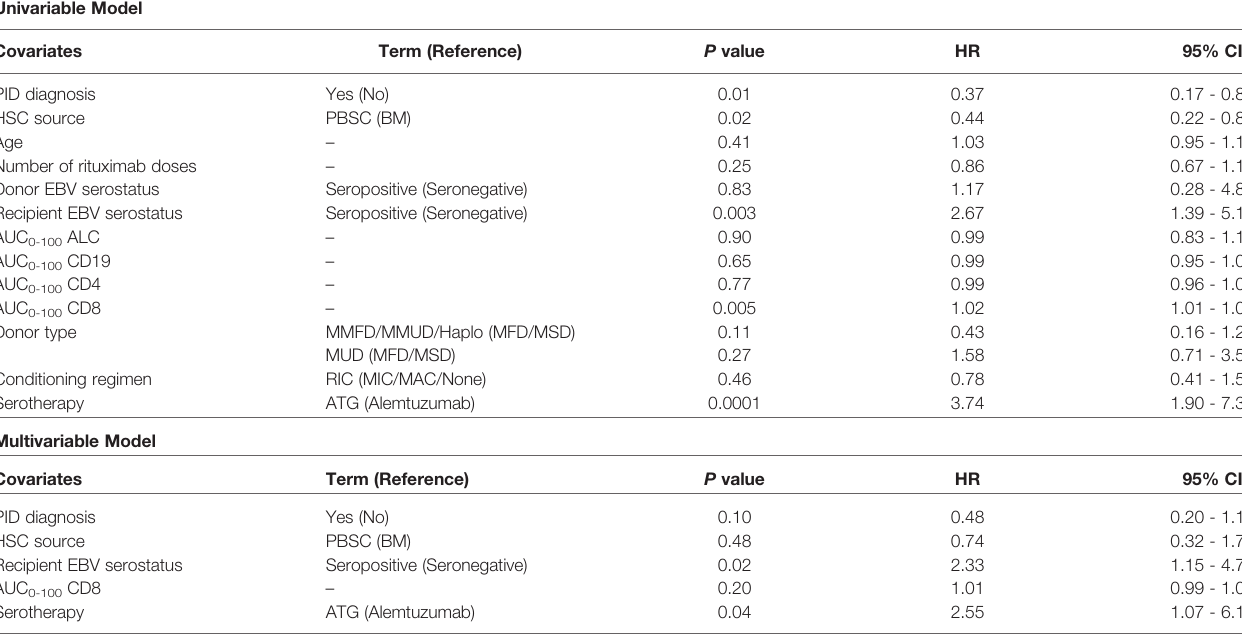
TABLE 2 | Univariate and multivariable Cox proportional hazards models for time to fi rst EBV reactivation in fi rst 100 days post-HSCT. Univariable Model Covariates